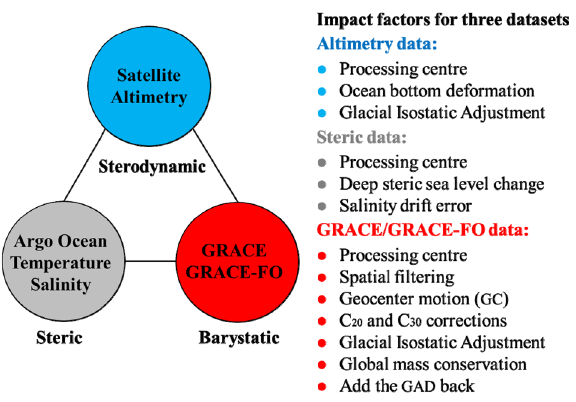
Figure 1. The impact factors of global sea-level change estimated from Altimetry, Argo and RL06 solutions of GRACE/GRACE-FO